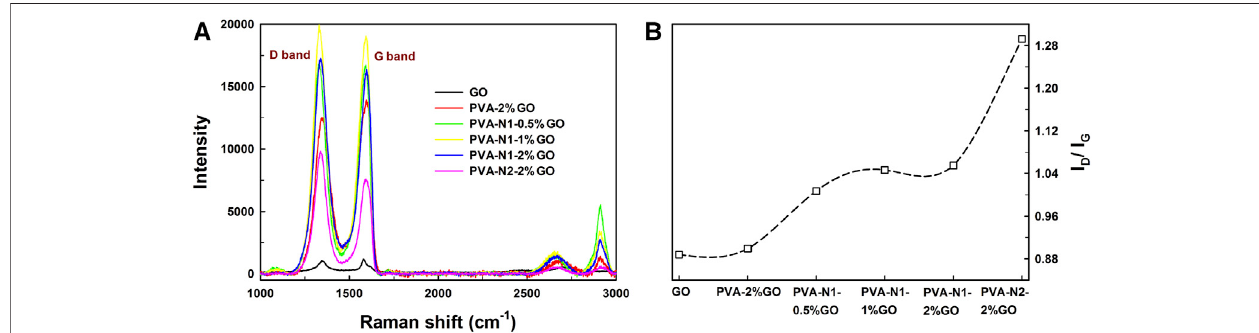
FIGURE 3 | Raman spectroscopy curves (A) and plotted I D /I G ratios (B) of GO and nanocomposites.